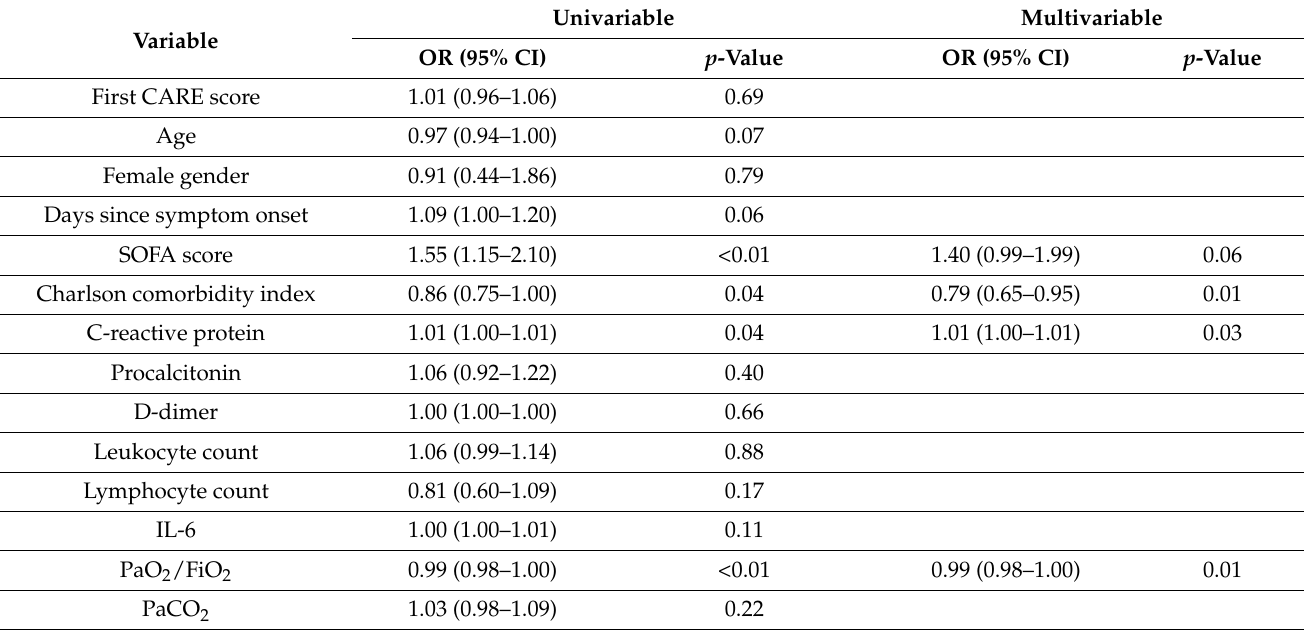
Table 4. Logistic regression for endotracheal